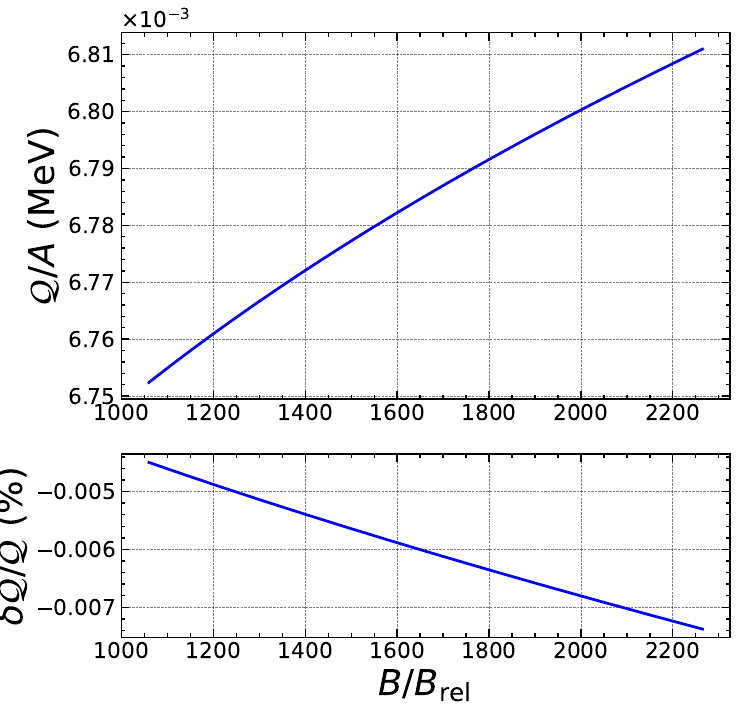
Figure 14. Same as Figure 13 in the strongly quantizing